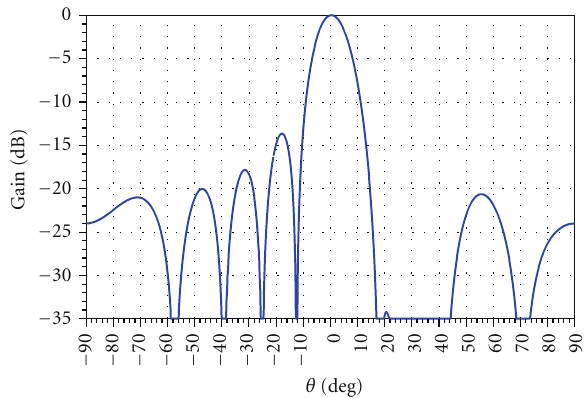
Figure 4: Adapted pattern of 10-element linear array with 4- narrowband jammers located in sidelobe region (18 ◦ , 25 ◦ , 33 ◦ , 42 ◦ ).